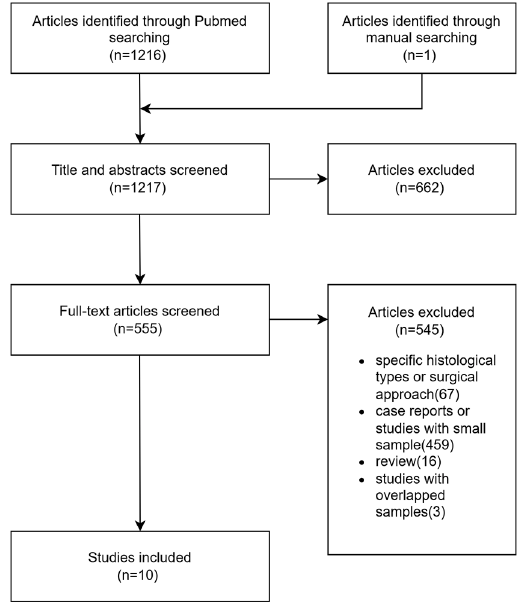
Figure 1. Flow diagram of the selected studies.